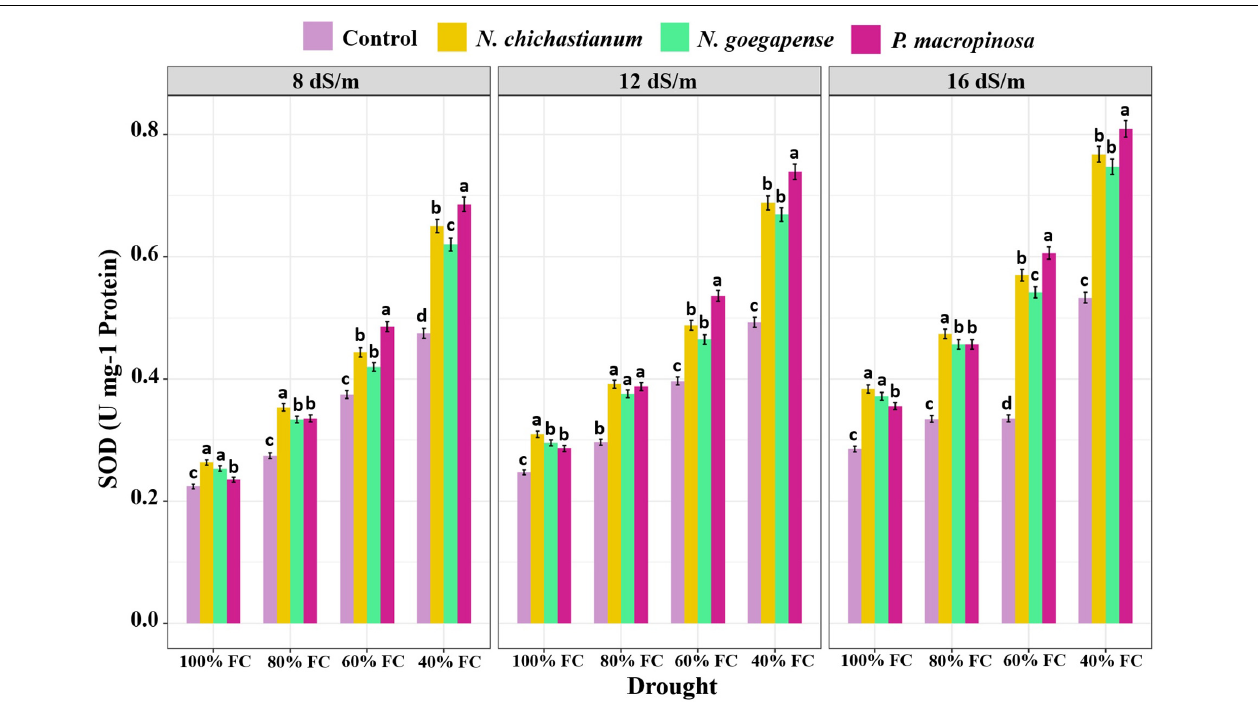
FIGURE 6 | The effects of halotolerant endophytic fungi species on SOD activity of barley plants under salinity and drought stress. Different levels of drought stress and different fungal treatment are shown on the horizontal axis and colorful bars, respectively. Various letters on the top of bars display significant differences between mean values of different fungal treatments under the different levels of salinity and drought stress at p ≤